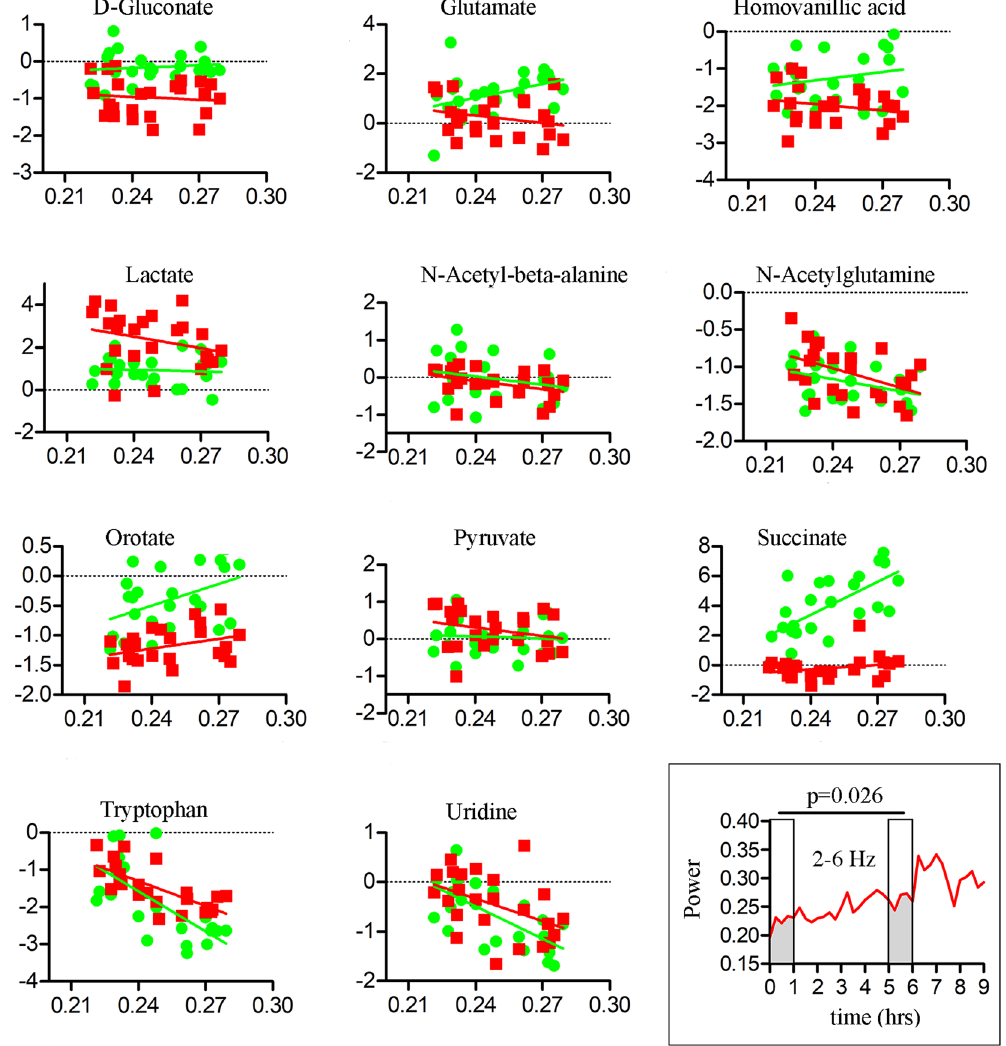
Figure 5. Correlations between levels of each compound (log transformed; y axis) and 2–6 Hz EEG activity during wakefulness (x axis). Data and regression lines are depicted in green for mPFC and red for M1. The inset (bottom right) shows the averaged time course (n = 6 mice) of 2–6 Hz activity during the EW6-S3 experiment. Note the progressive increase in 2–6 Hz activity in the course of EW. Abbreviations: mPFC, medial prefrontal cortex; M1, primary motor cortex; EW, enforced wakefulness; S,